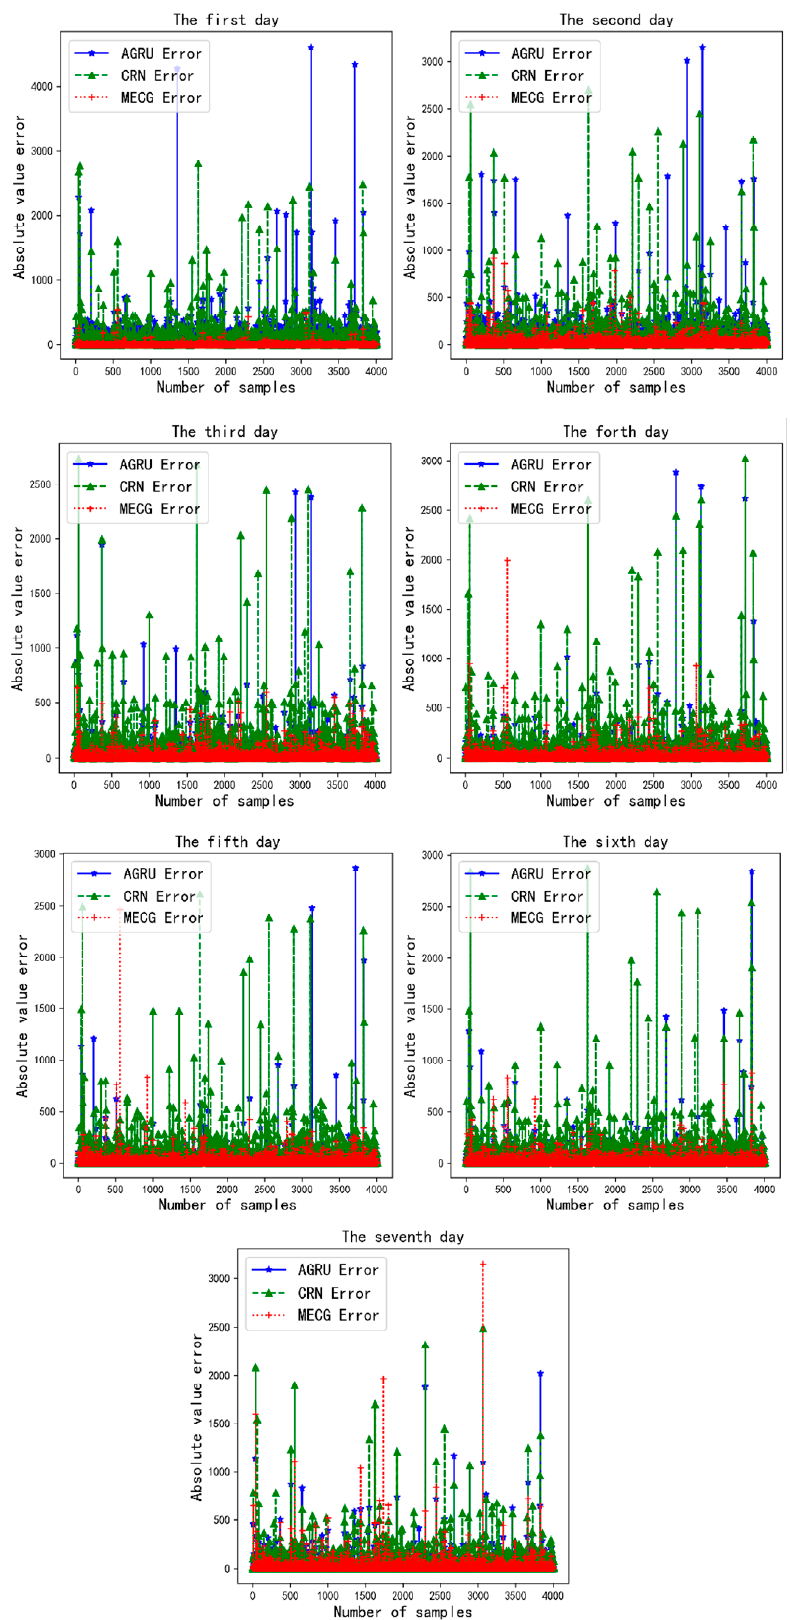
Figure 8. Absolute error chart of all samples.